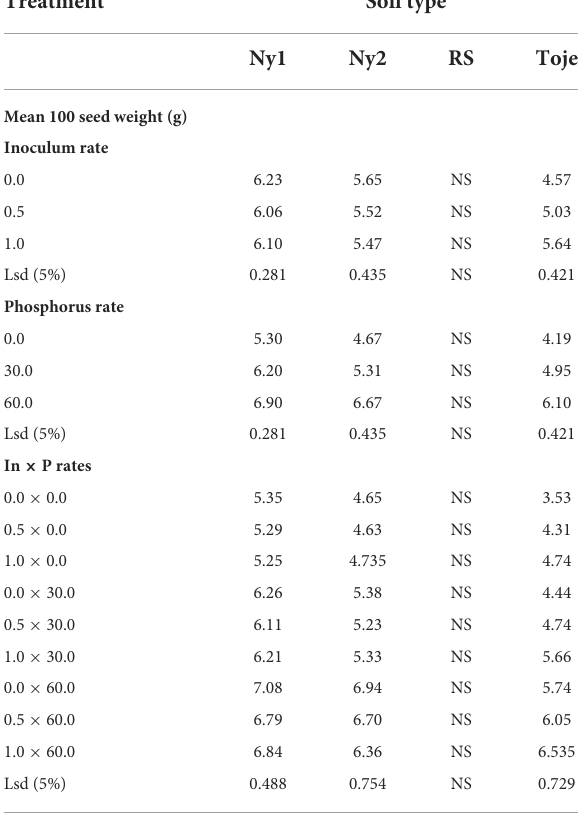
TABLE 6 Effect of rates of Histick Soy and P on seed weight * . Treatment